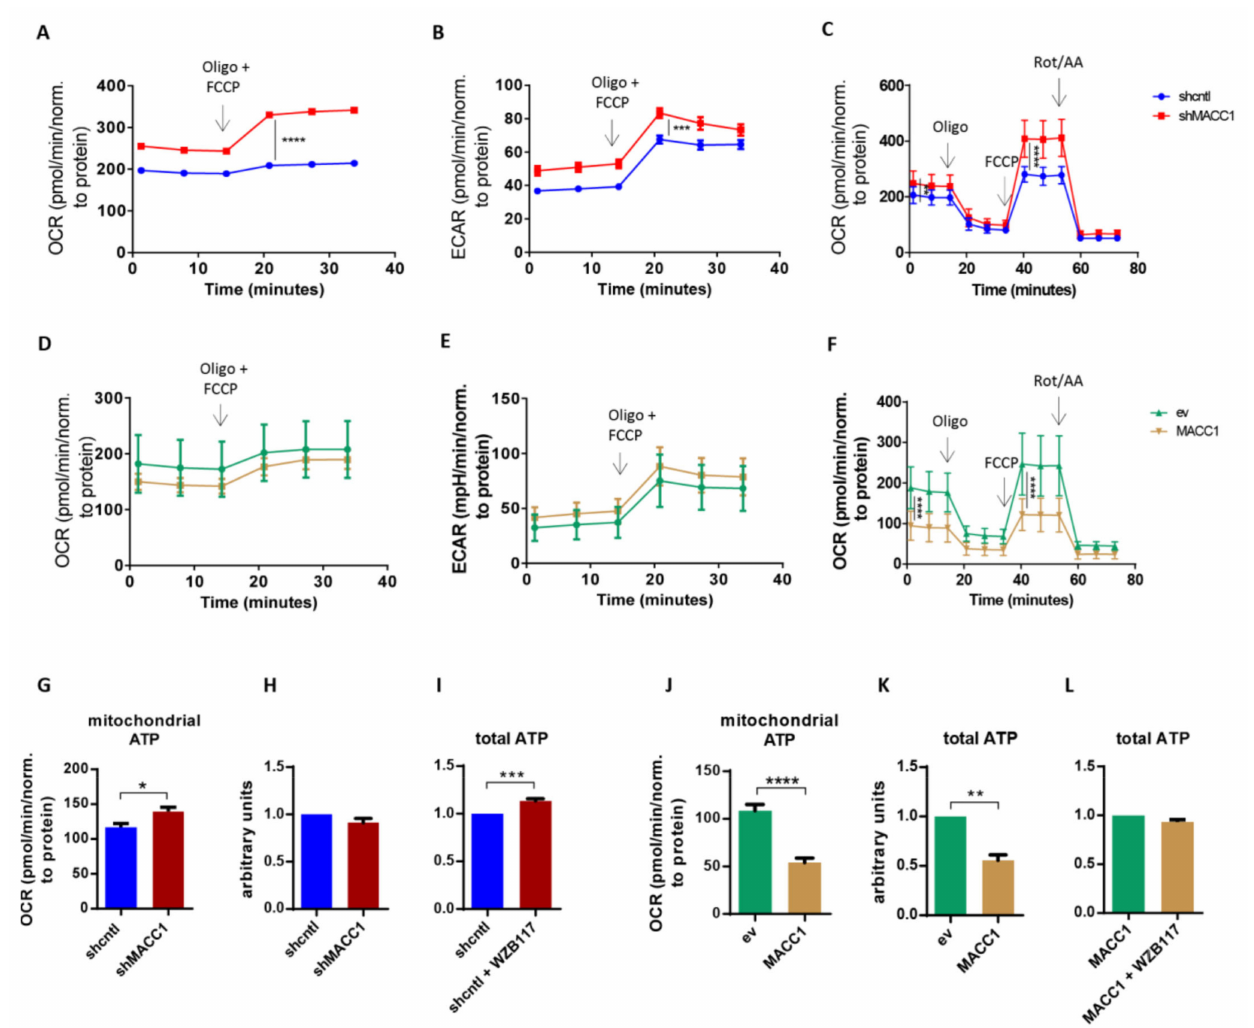
Figure 3. Decreases of mitochondrial respiration and spare respiratory capacity by MACC1. ( A ) Oxygen consumption rate (OCR) and ( B ) extracellular acidification rate (ECAR) of SW620 shcntl and SW620 shMACC1 cells treated with both oligomycin (Oligo) and FCCP. ( C ) OCR of cells as in ( A , B ), treated with Oligo/FCCP and rotenone/antimycin A (Rot/AA). ( D ) OCR and ( E ) ECAR of SW480 empty vector (ev) and MACC1 overexpressing (MACC1) cells treated with the mixture of Oligo/FCCP. ( F ) OCR of cells as in ( D , E ) treated with Oligo/FCCP and Rot/AA. ( G ) Mitochondrial and ( H ) total ATP in SW620 shcntl and SW620 shMACC1 cells without or, ( I ) with GLUT1 inhibitor WZB117. ( J ) Mitochondrial and ( K ) total ATP in SW480 ev and SW480 MACC1 cells without or, ( L ) with GLUT1 inhibitor WZB117. * p ≤ 0.05, ** p ≤ 0.01, *** p ≤ 0.001, **** p ≤ 0.0001. Data represent mean values ± SEM of at least three independent